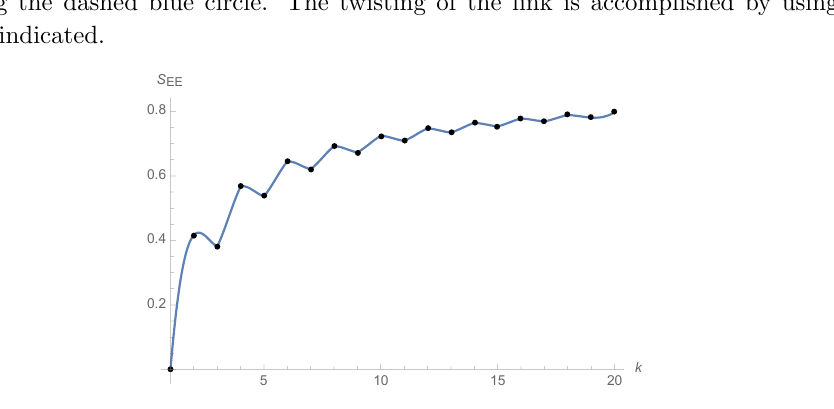
. This is a special case of the family of links 2 N 2 1